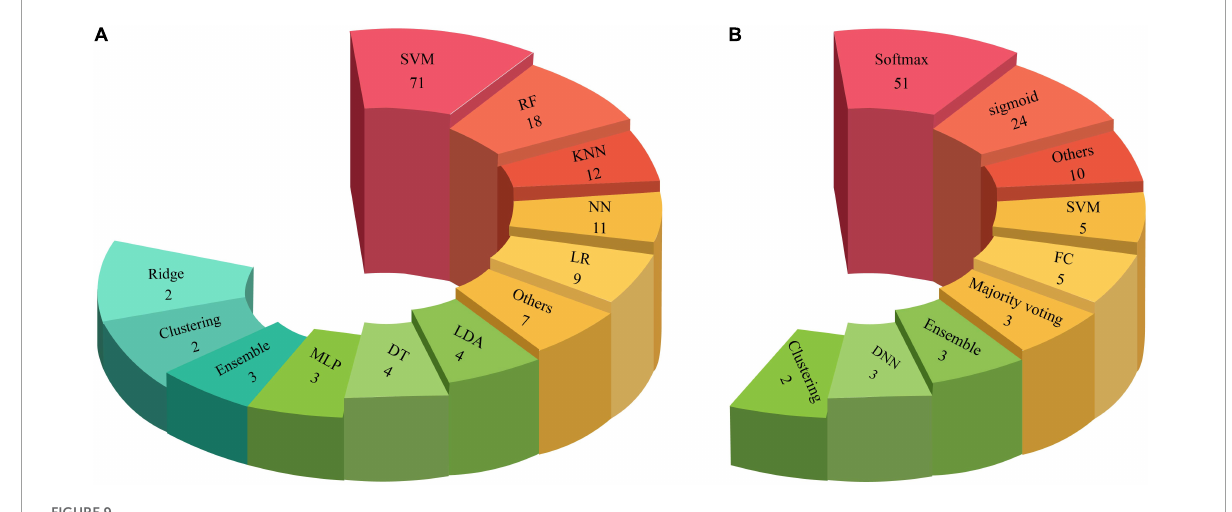
FIGURE9 Number of classifiers used in CADS for ASD detection: (A) ML and (B) DL